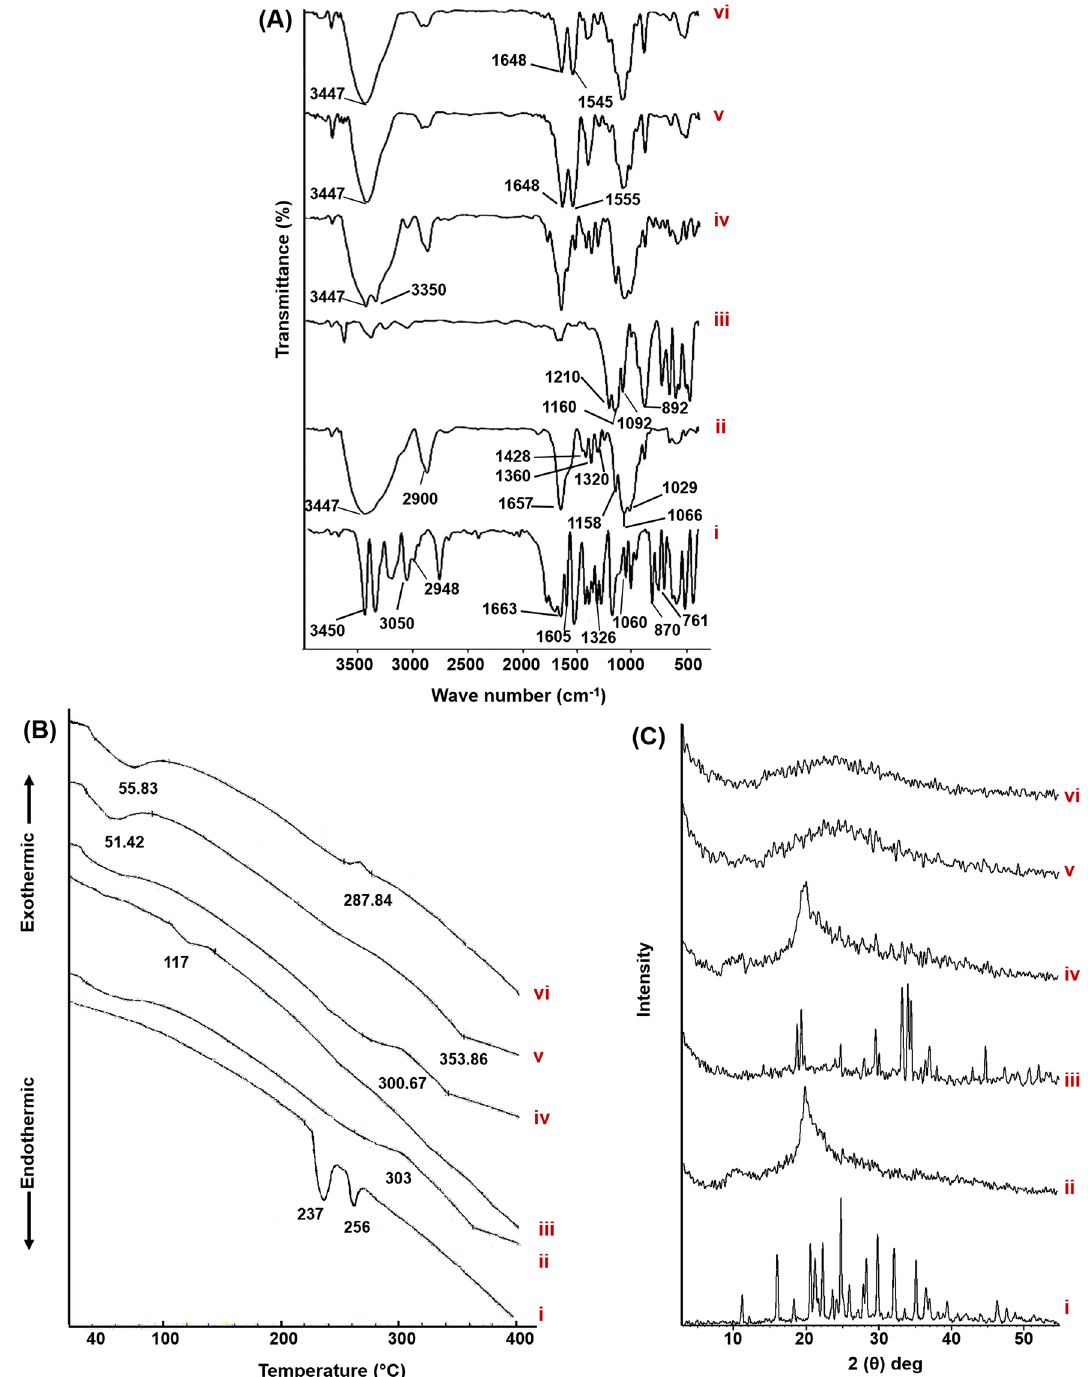
Figure 6. Solid characterization. ( A ) FT-IR spectra, ( B ) DSC thermograms, and ( C ) PXRD patterns of pure ALL ( i ), CS ( ii ), STPP ( iii ), physical mixture of ALL, CS and STPP ( iv ), plain CS/STPP NPs ( v ) and ALL-loaded CS/STPP NPs (F-9) ( vi ). DSC thermograms were fitted with a Shimadzu TA-60 series (https ://www.ssi.shima dzu.com/produ cts/therm al-analy sis/labso lutio ns-ta-softw